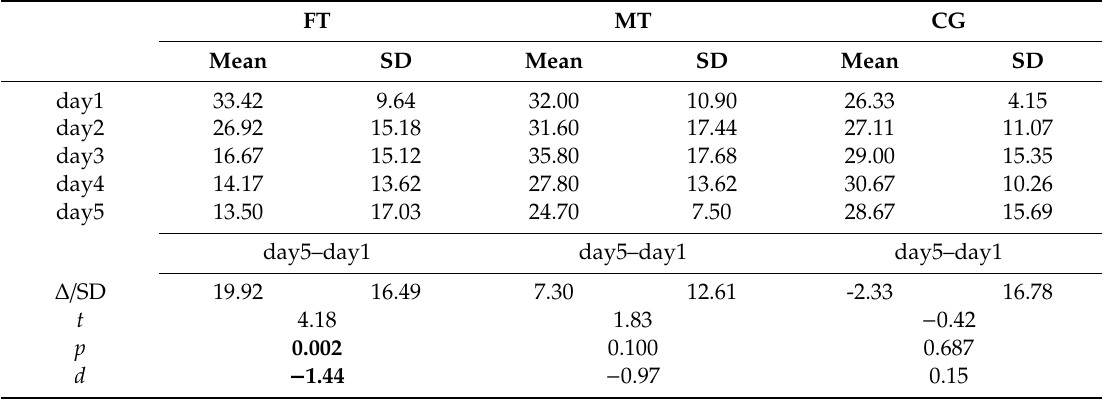
Table A3. Mean values and e ff ect sizes for Deck B within